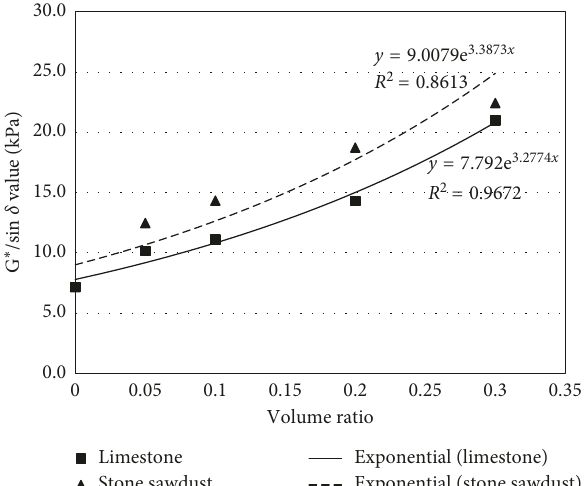
Figure 6: Rutting behavior of asphalt mastics at 50 ° C.